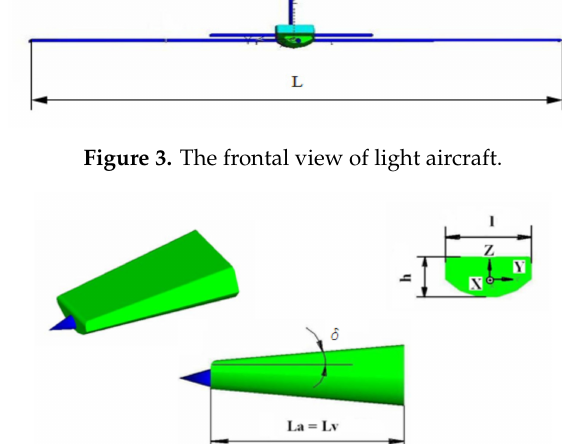
Figure 2. Lateral view of a new light aircraft.